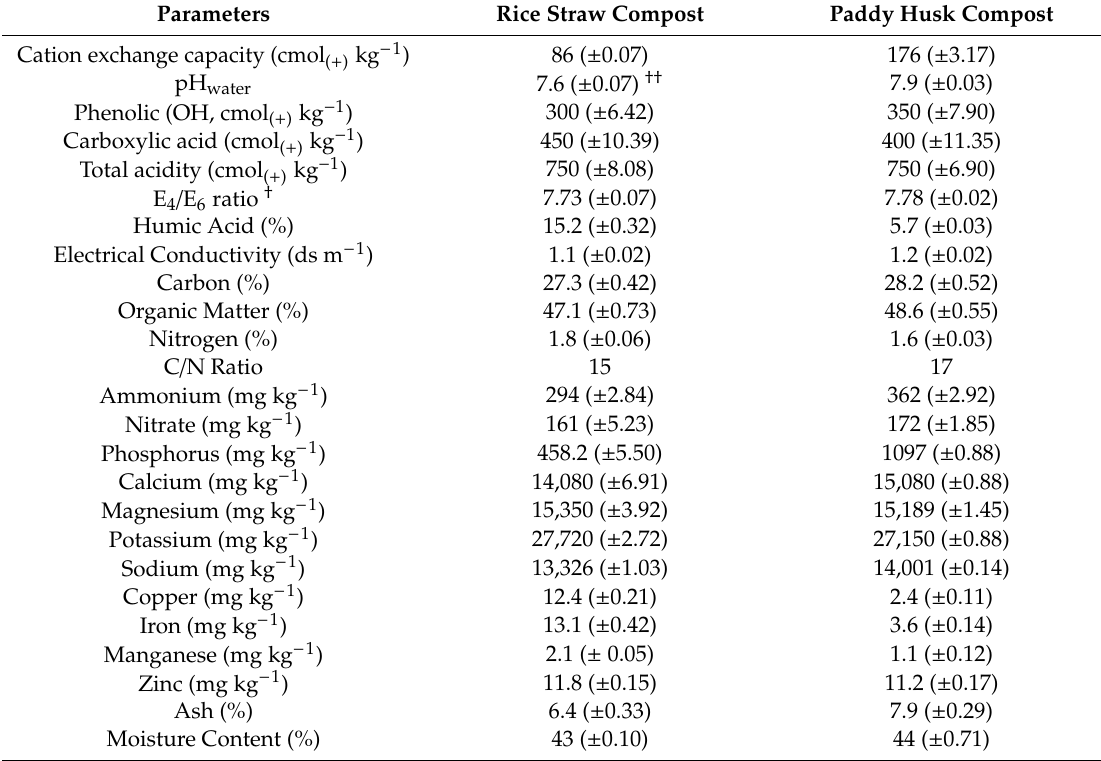
Table 2. Some physico-chemical characteristics of the rice straw and paddy husk